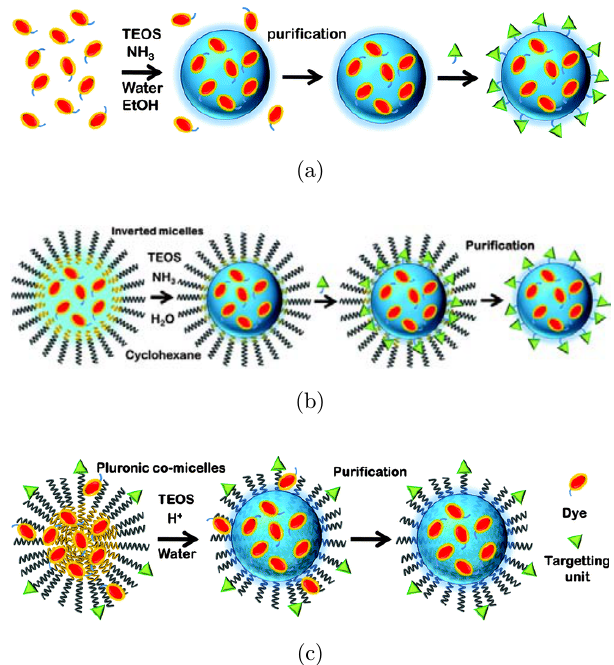
Fig. 1. Scheme of methods employed for the synthesis of SNP. (a) The sol-gel method in which the hydrolysis and condensa- tion reactions using alkaline catalysis. (b) The reverse phase microemulsion (W/O) in which TEOS is hydrolyzed at the micellar interface and enters the aqueous droplet to form a SNP within the micelle. (c) The direct phase microemulsion (O/W) in which organotrialkoxysilane precursors are hydrolyzed within the nonpolar core of surfactant microemulsion. Repro- duced from Ref. 1 with permission of The Royal Society of